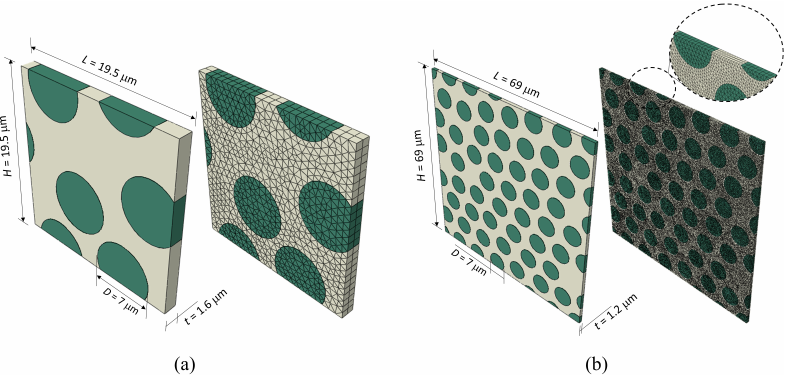
Figure 13. Geometry and mesh of the microscale RVE models used in this work: ( a ) VF40% with 4 fibres and ( b ) VF40% with 50